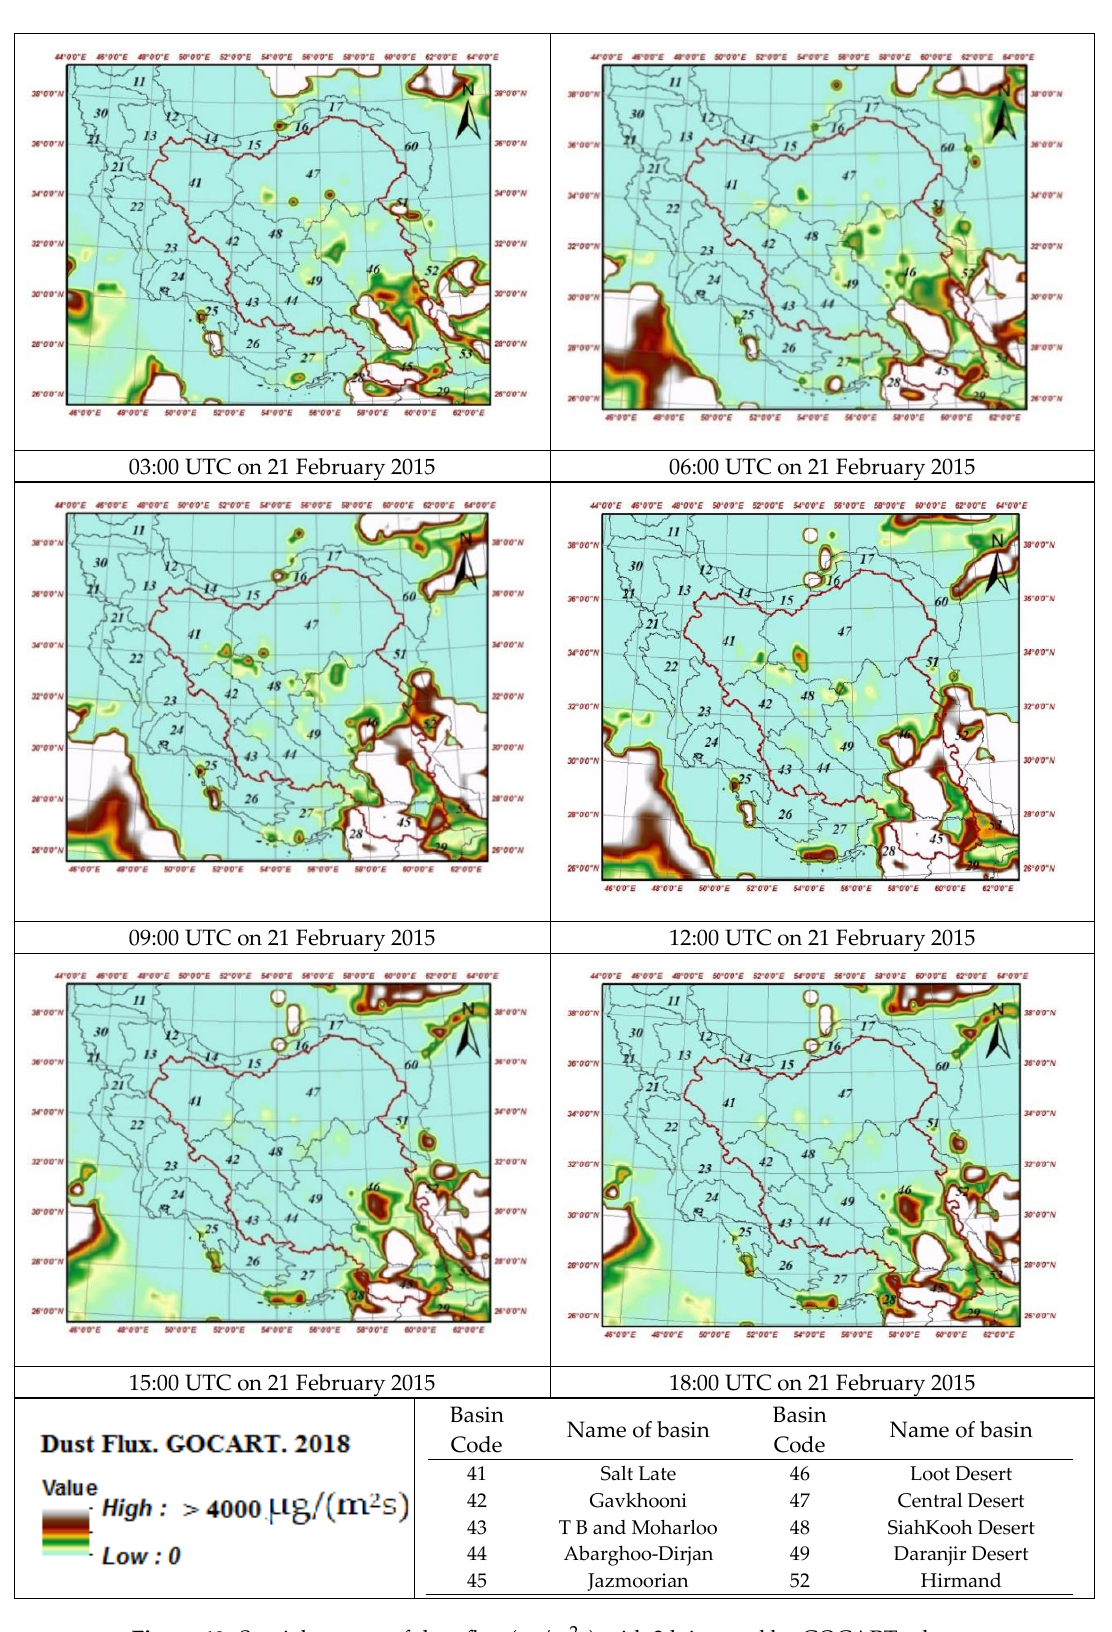
Figure 12. Spatial pattern of dust flux (µg/m 2 s) with 3 h interval by GOCART scheme.